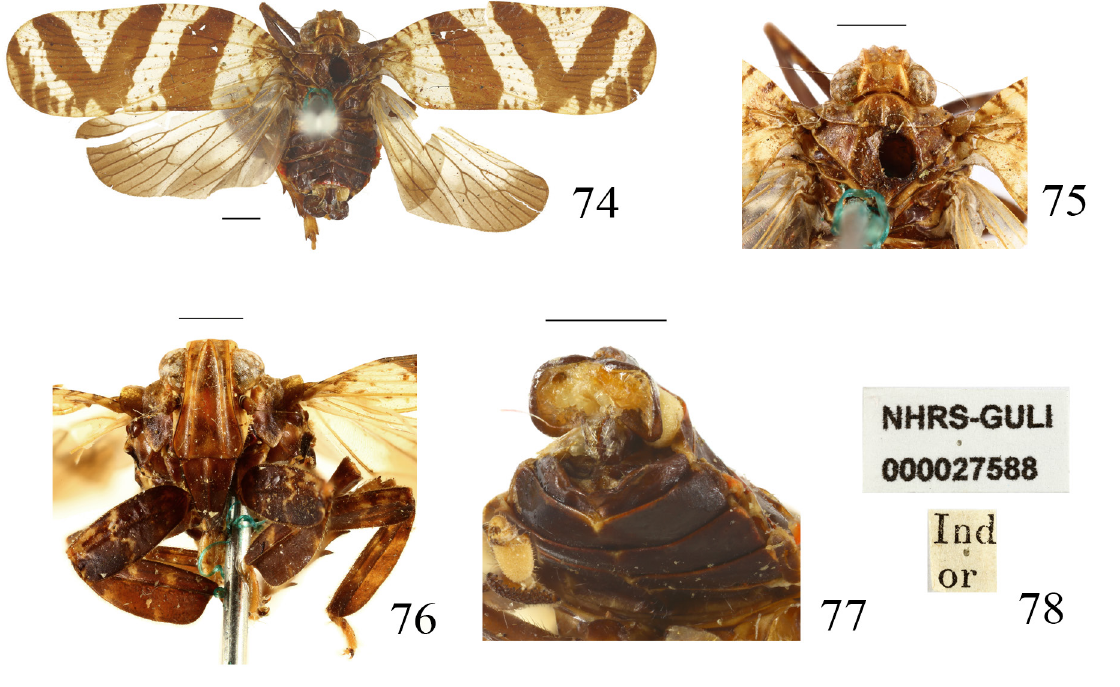
thorax, dorsal view. 76 . Frons and clypeus, frontal view. 77 . Female terminalia, ¾ ventral view. 78 . Labels. Scale bars = 1